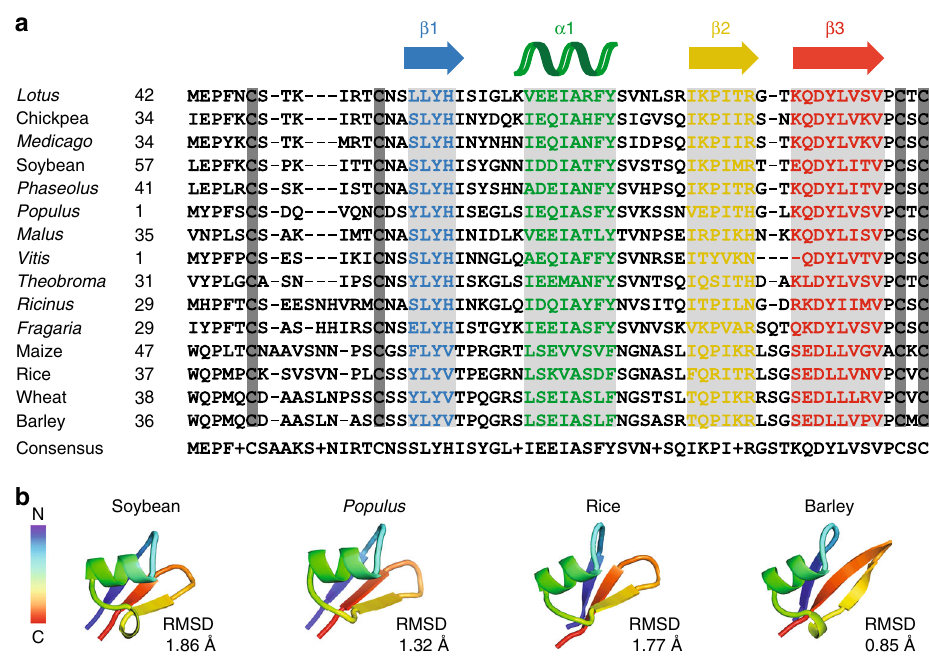
Fig. 2 M1 is a de fi ning feature of a unique class of plant receptors. a Amino acid sequence alignment of M1 from Lotus EPR3 and EPR3 receptor homologues found in dicots (legumes and non-legumes) and monocots showing the conserved βαββ secondary structure arrangement. b Ab initio models of the EPR3-M1 domain from receptor homologues reveal conserved βαββ structures. Molecular fi ts (RMSD values) based on superposition of these modelled M1 domains to the M1 domain in the EPR3 crystal structure are denoted in Å